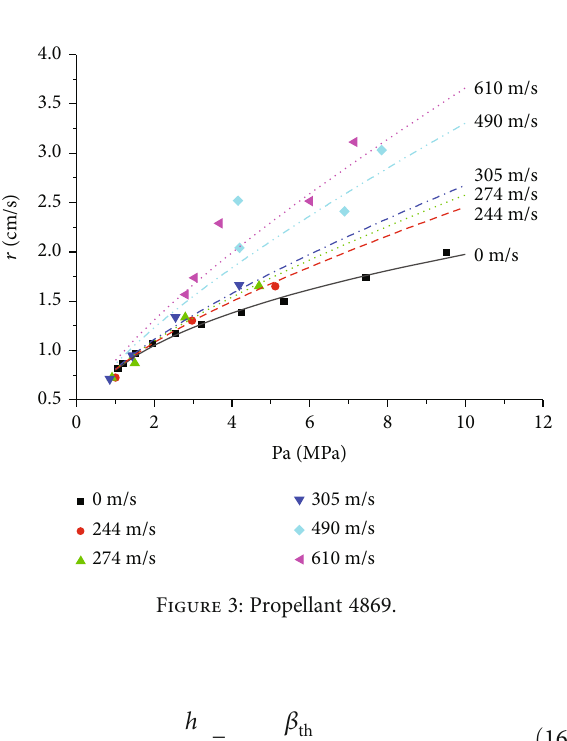
Figure 4: Propellant